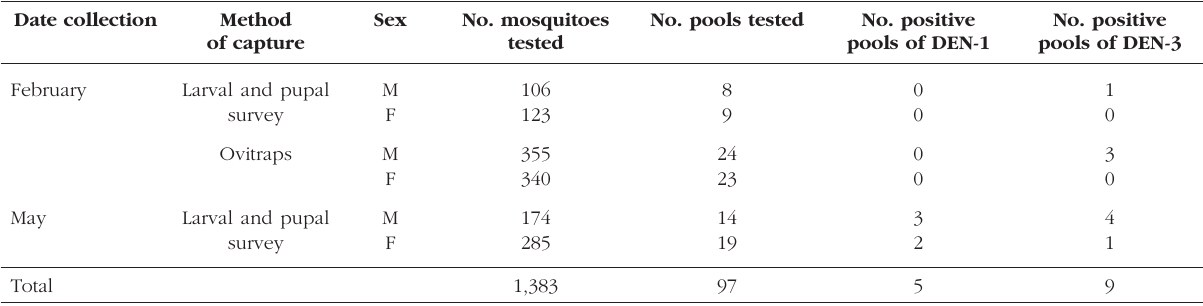
Table I. – Numbers of mosquitoes, pools tested and dengue isolates in 2007 in the city of Santa Cruz de la Sierra,